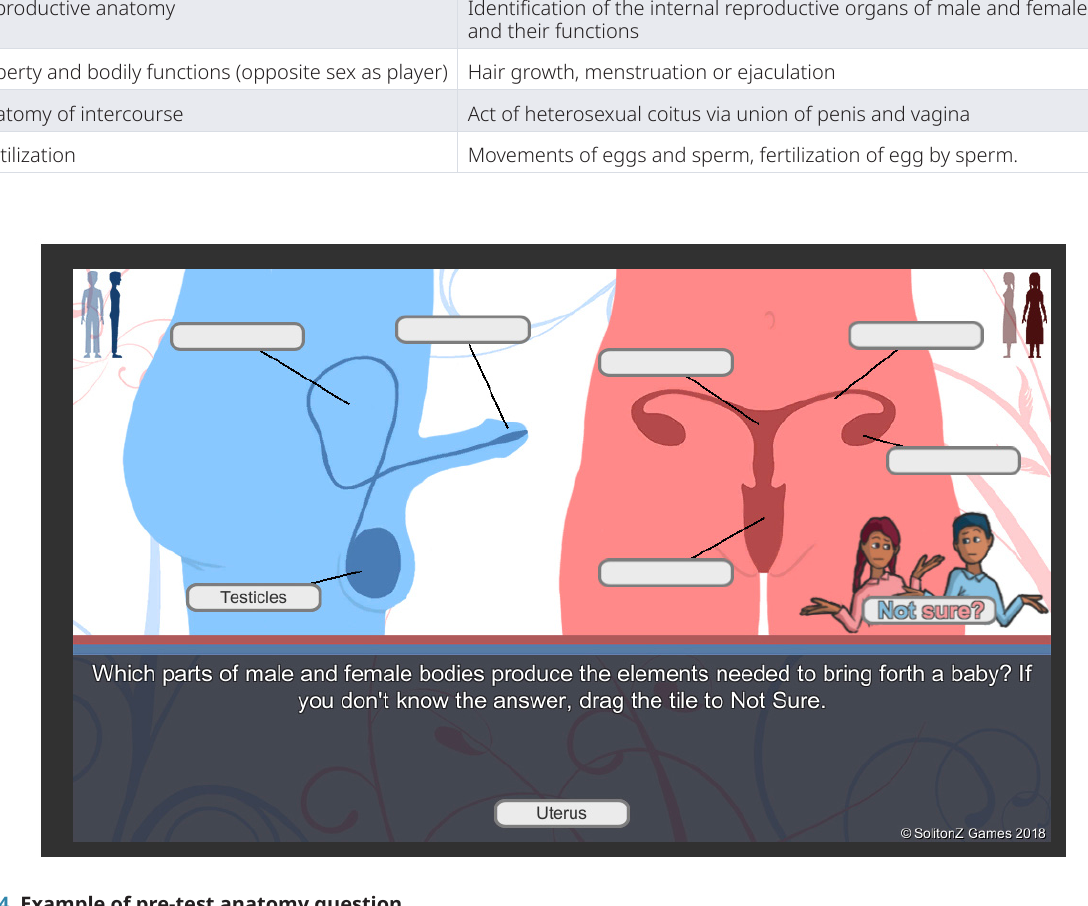
Figure 4. Example of pre-test anatomy